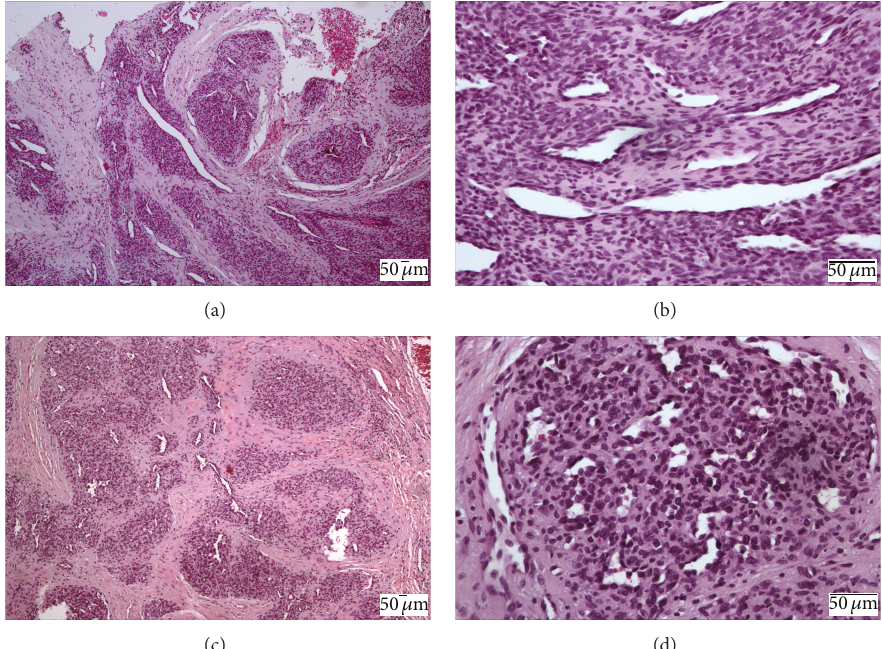
Figure 2: The microscopic examination revealed an endothelial cell proliferation in nodular arrangements with a “cannon ball” pattern coveredbyoralmucosa.Theformationofirregularcapillarybloodvesselswithaslit-shapedlumenwasalsoobserved.(a)and(b):microscopic features of case 1. (c) and (d): microscopic features of case 2.